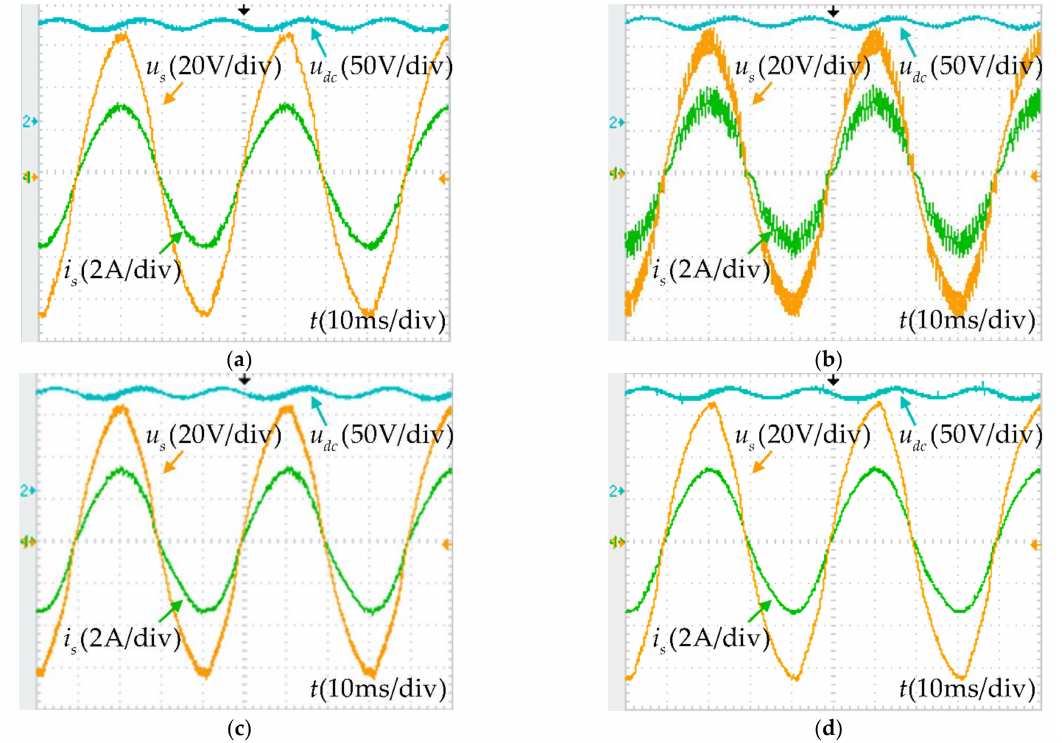
Figure 15. Experimental waveforms of AC voltage, input current, and DC-link voltage. ( a ) PI-ICC; ( b ) FCS-MPC; ( c ) MP- DPC; ( d ) the proposed MPCC.